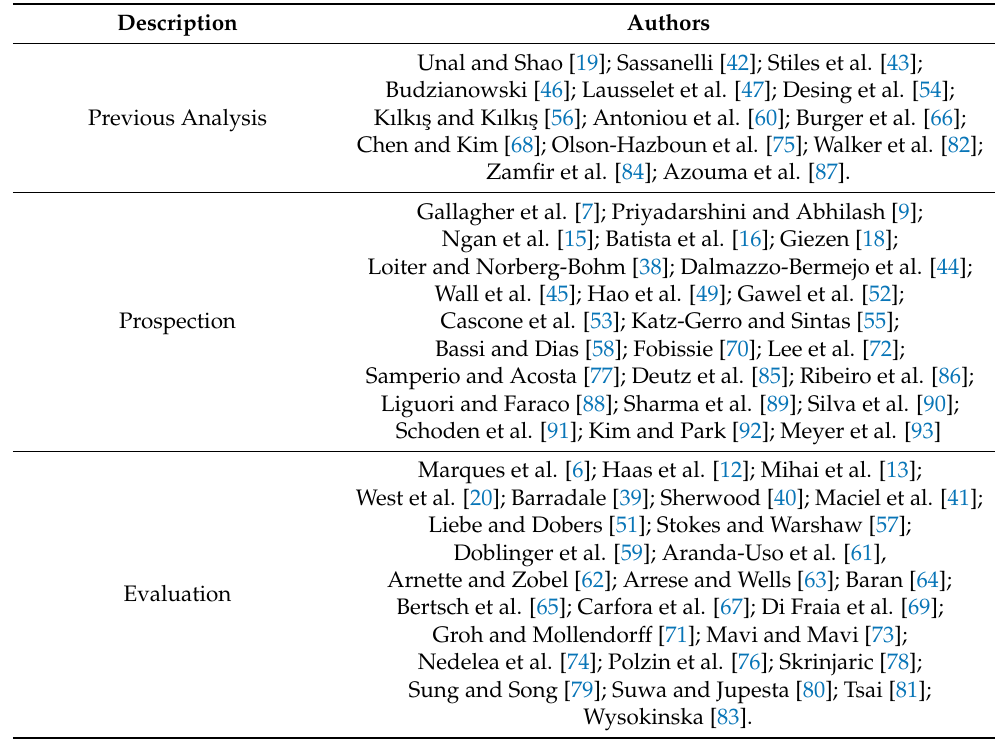
Table 6. Classification of articles in terms of associated benefits at each stage of the public policy